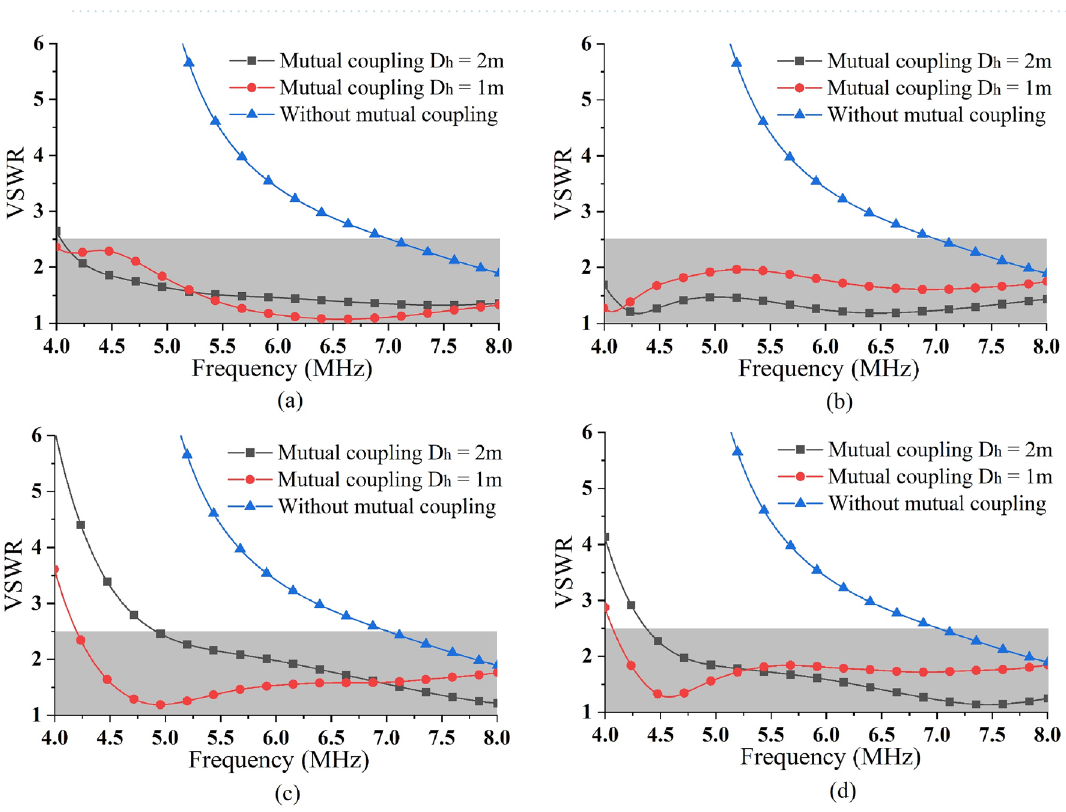
Figure 7. Simulated results of VSWR for ( a ) Port 1, ( b ) Port 2, ( c ) Port 3 and ( d ) Port